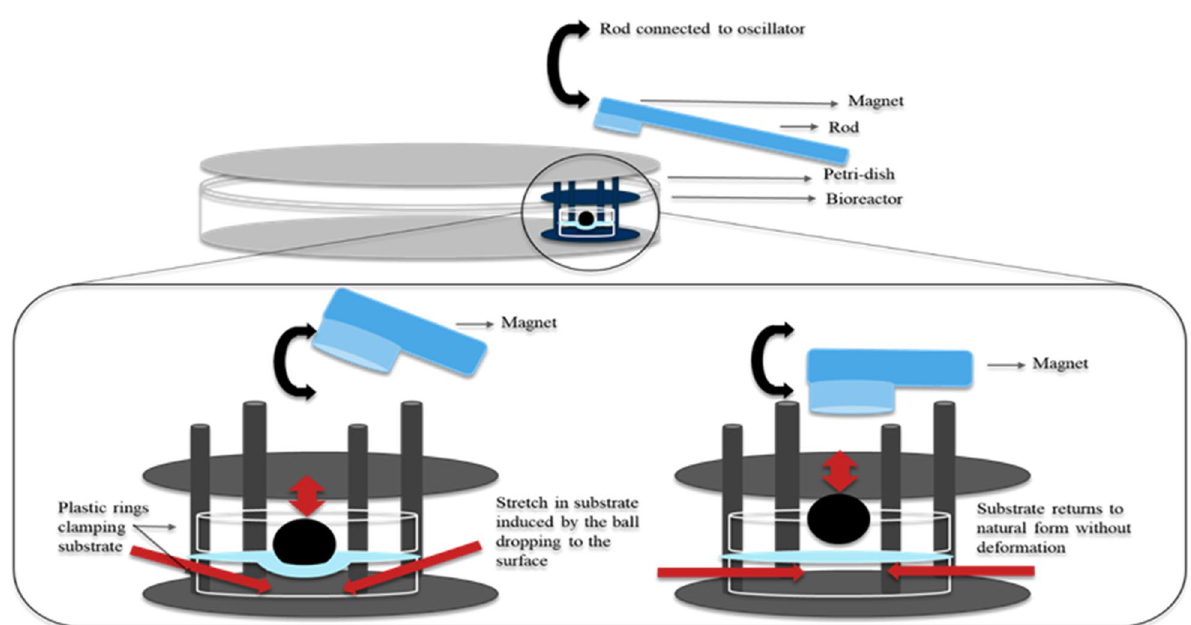
Figure 5. Diagram showing the external loading system to exert cyclical force on fetal membranes. A moving rod attaching with a magnet driven by a rocker lifted and dropped the metallic ball to fetal membranes alternately while the whole loading system was placed in an incubator at 37 °C and 95% CO 2